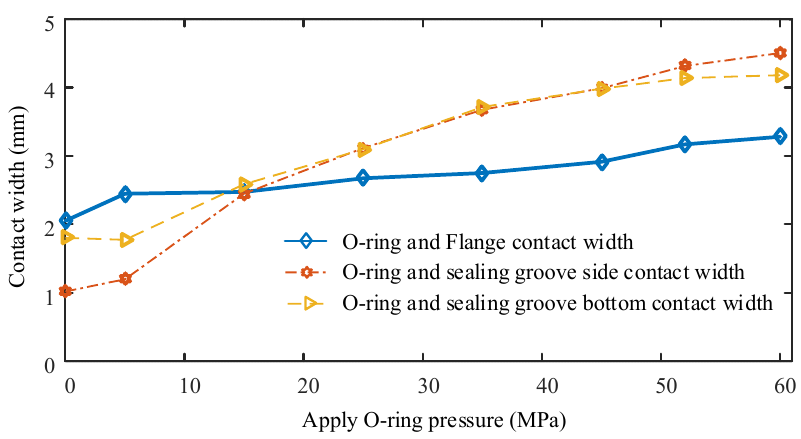
Figure 15. Contact width affected by medium pressure.